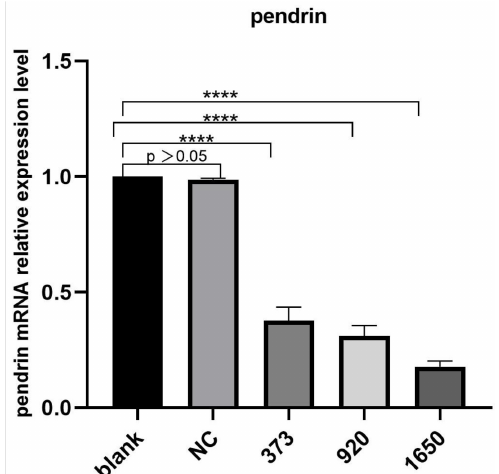
Figure 4. After transfection with siRNA pendrin (NC, pendrin-373, pendrin-920, pendrin-1650, and FAM NC), the mRNA expression of pendrin was downregulated. **** represents p <